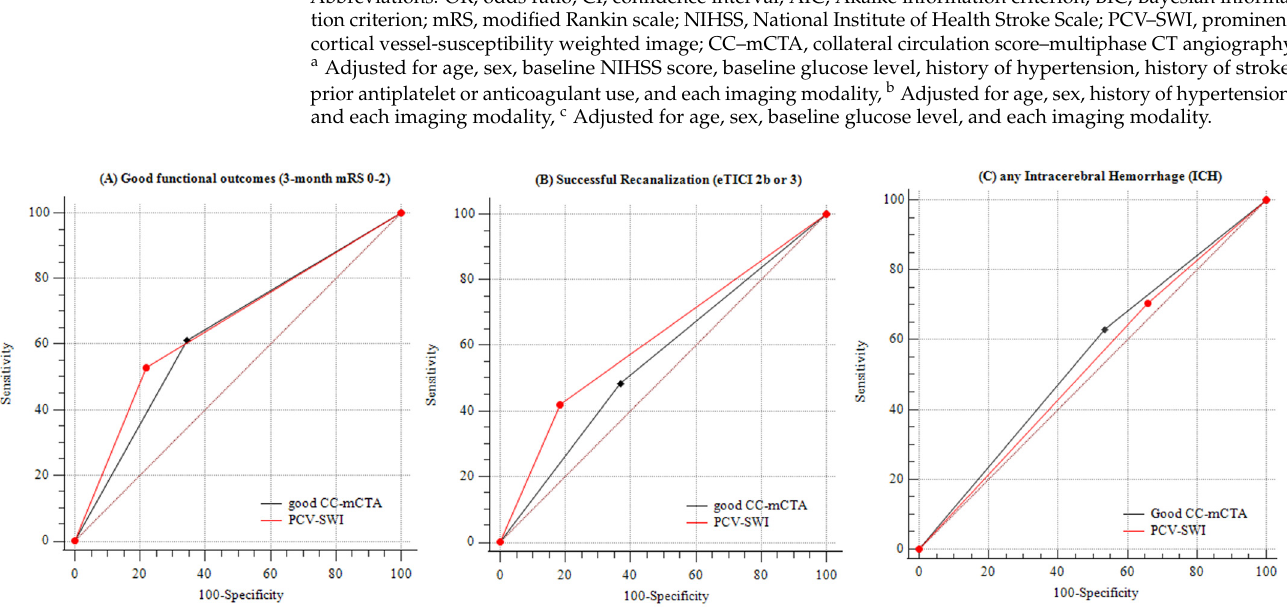
Figure 2. The comparison of AUCs between PCV–SWI and good collaterals–mCTA. ( A ) for predicting functional outcomes at 3 months, ( B ) for predicting achievement of successful recanalization, and ( C ) for predicting any intracerebral hemorrhage.